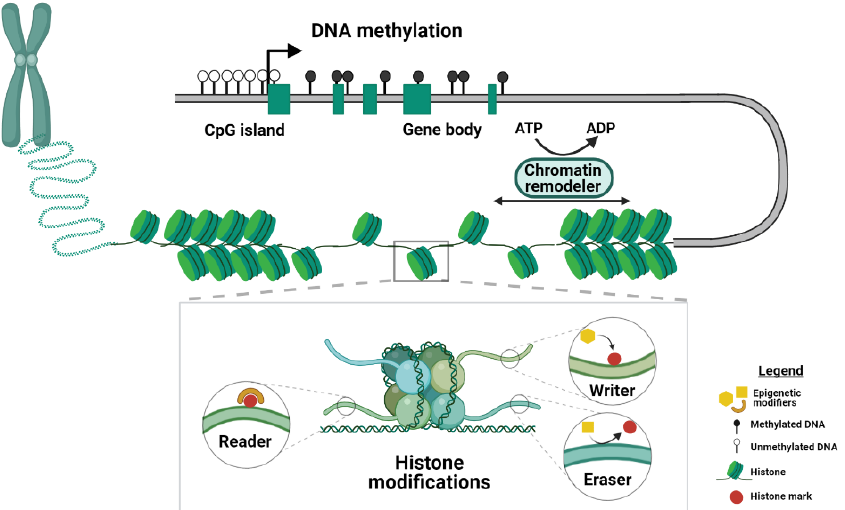
Figure 1. Schematic of the mechanisms of epigenetic regulation. DNA methylation, histone modifications and chromatin remodeling represent three different kinds of epigenetic mechanisms. Main players in the histone modification machinery are depicted in the inset. Proteins that covalently attach chemical groups to the histone tails are termed writers, whereas the so-called readers can recognize and bind to histone modifications. Enzymes that remove histone marks are termed erasers. DNA methylation is found across different genomic elements. For example, CpG islands, which are often found in the proximity of promoters, are usually depleted of methylation, whereas gene bodies are heavily methylated. The chromatin structure is controlled by chromatin remodeler complexes that use the hydrolysis of ATP to mediate the packaging of the chromatin. Created with BioRender.com.